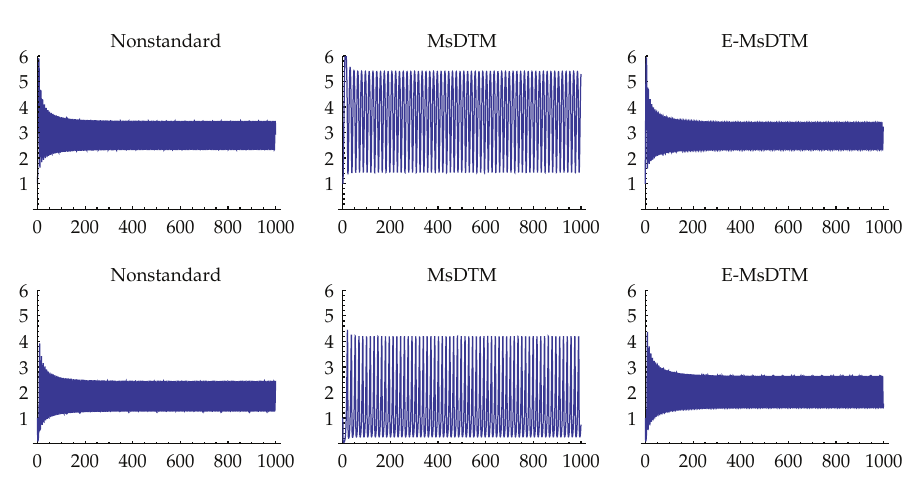
Figure 11: x (cid:4) t (cid:5) (cid:4) Top (cid:5) and y (cid:4) t (cid:5) (cid:4) Bottom (cid:5) ; nonstandard scheme (cid:4) Left, h (cid:8) 0 . 01 (cid:5) , MsDTM (cid:4) Middle, h (cid:8) 0 . 125 (cid:5) , √ E-MsDTM (cid:4) Right, h (cid:8) 0 . 125 (cid:5) k (cid:8) 32 2 / 7 (cid:9) 0 .